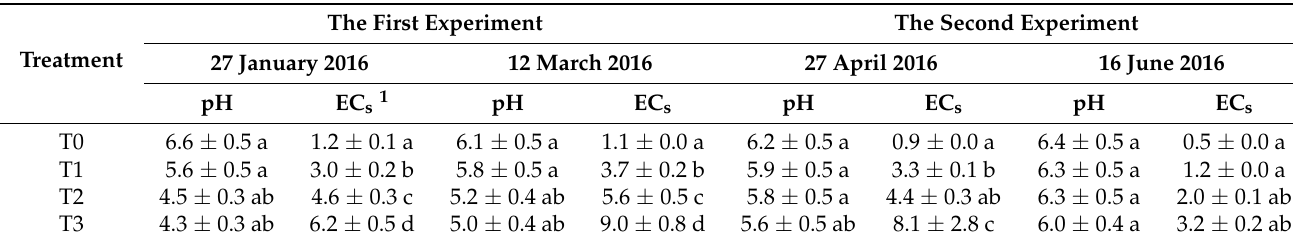
Table 2. The pH and electrical conductivity (EC s ) of the soil. Different letters within a column represent significant differences ( p ≤